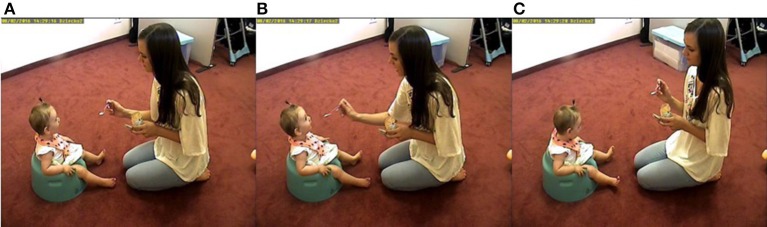
Example frames of the interaction during the feeding task. First, the mother leans forward to feed her baby (A). Then, the baby leans back anticipating the food while looking at her mother (B). Finally, the mother and the baby move back to the original position (C). This process is repeated throughout the interaction. Parents gave written consent to use the images in the publication.